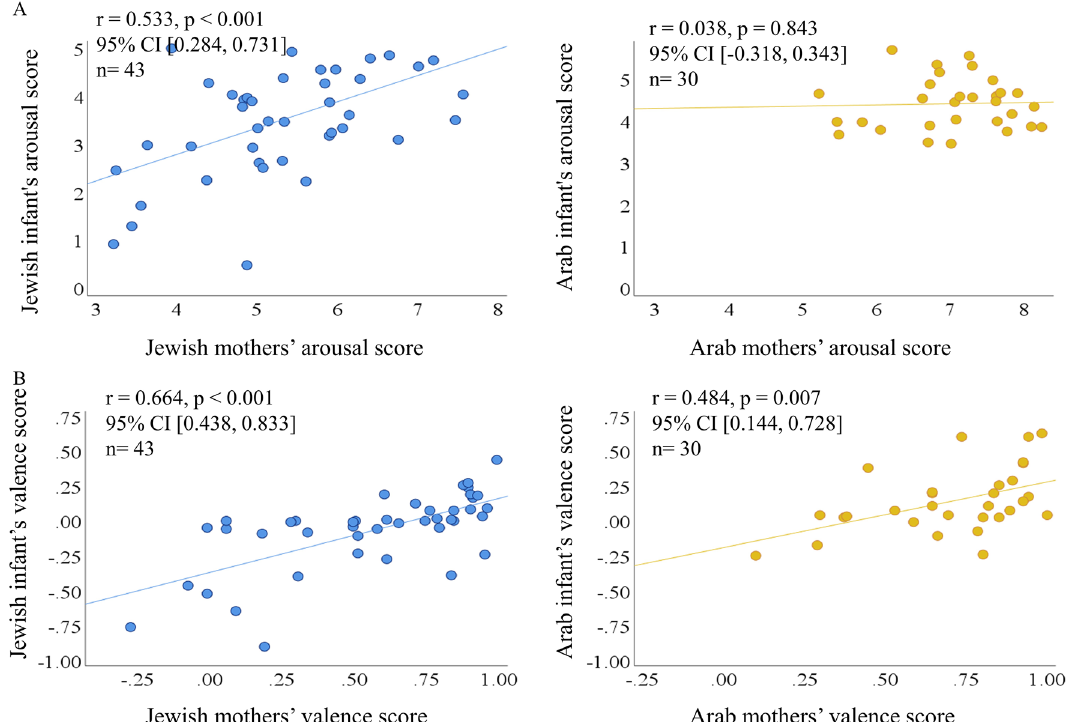
Figure 4. Mother–infant mutual affective match in Arab and Jewish cultures. ( A ) Mutual match between mothers and their infants in arousal only in Jewish dyads. ( B ) Mutual match between mothers and their infants in valence in Jewish and Palestinian-Arab